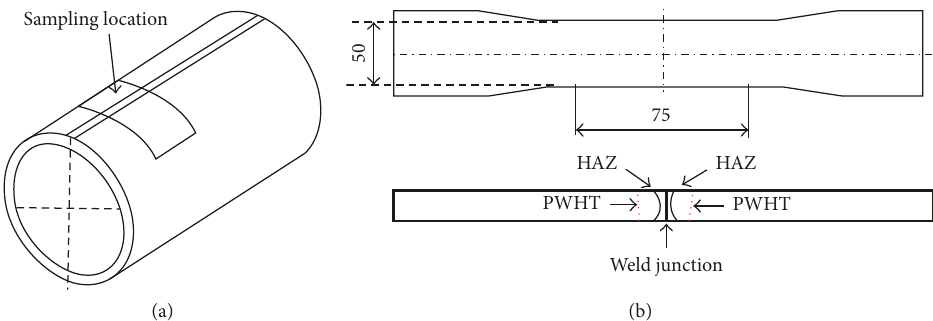
Figure 1: (a) Schematic illustration of the locations of cut and preparation of the test specimens. (b) The critical dimensions of the fatigue test specimens (all dimensions are in